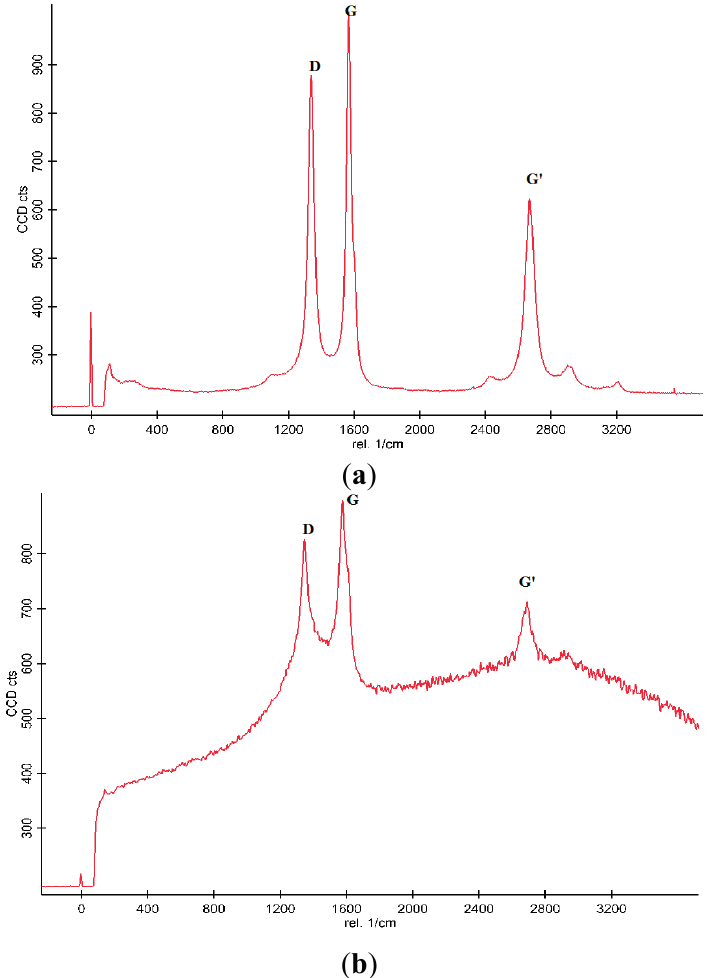
Figure 8. ( a ) Raman spectroscopy of Pristine MWCNT; and ( b ) Functionalized